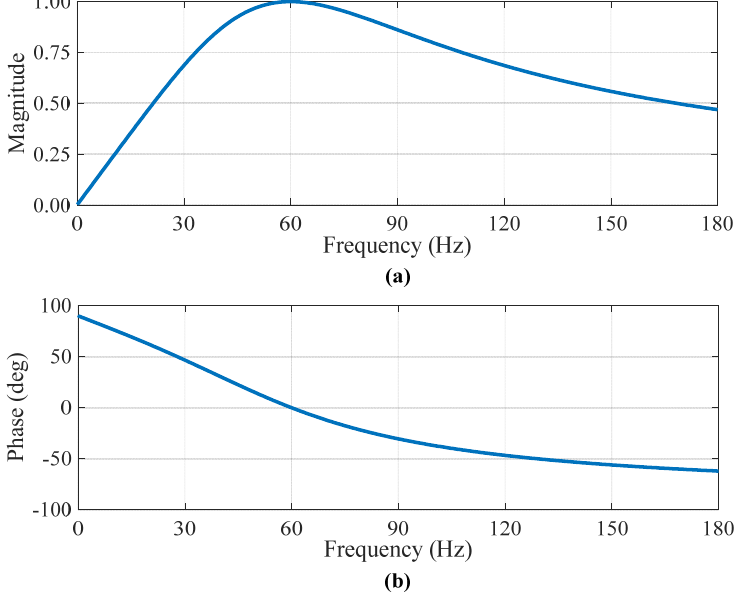
Figure 16. Frequency Response of the Band-Pass Filter Placed in the Power Hardware-in-the-Loop Simulation Model. ( a ) Magnitude plot. ( b ) Phase plot.